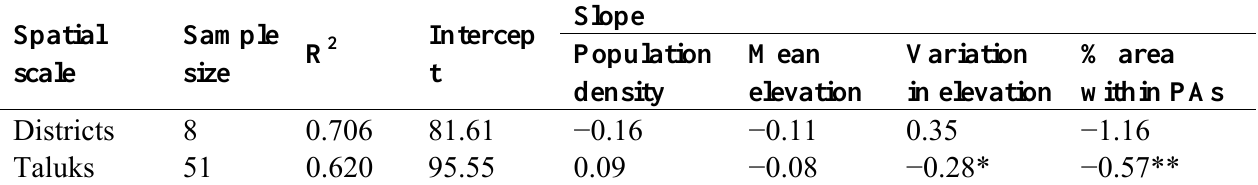
Table 3. Nature, strength and significance of four proposed drivers of forest change—population density, average elevation, variation in elevation and percentage within PAs—on the distribution of deforestation as a percentage of the forest cover in 2001, at the scale of districts and taluks. Results based on a linear multiple regression analysis. Significance codes: ** p < 0.01, * p <